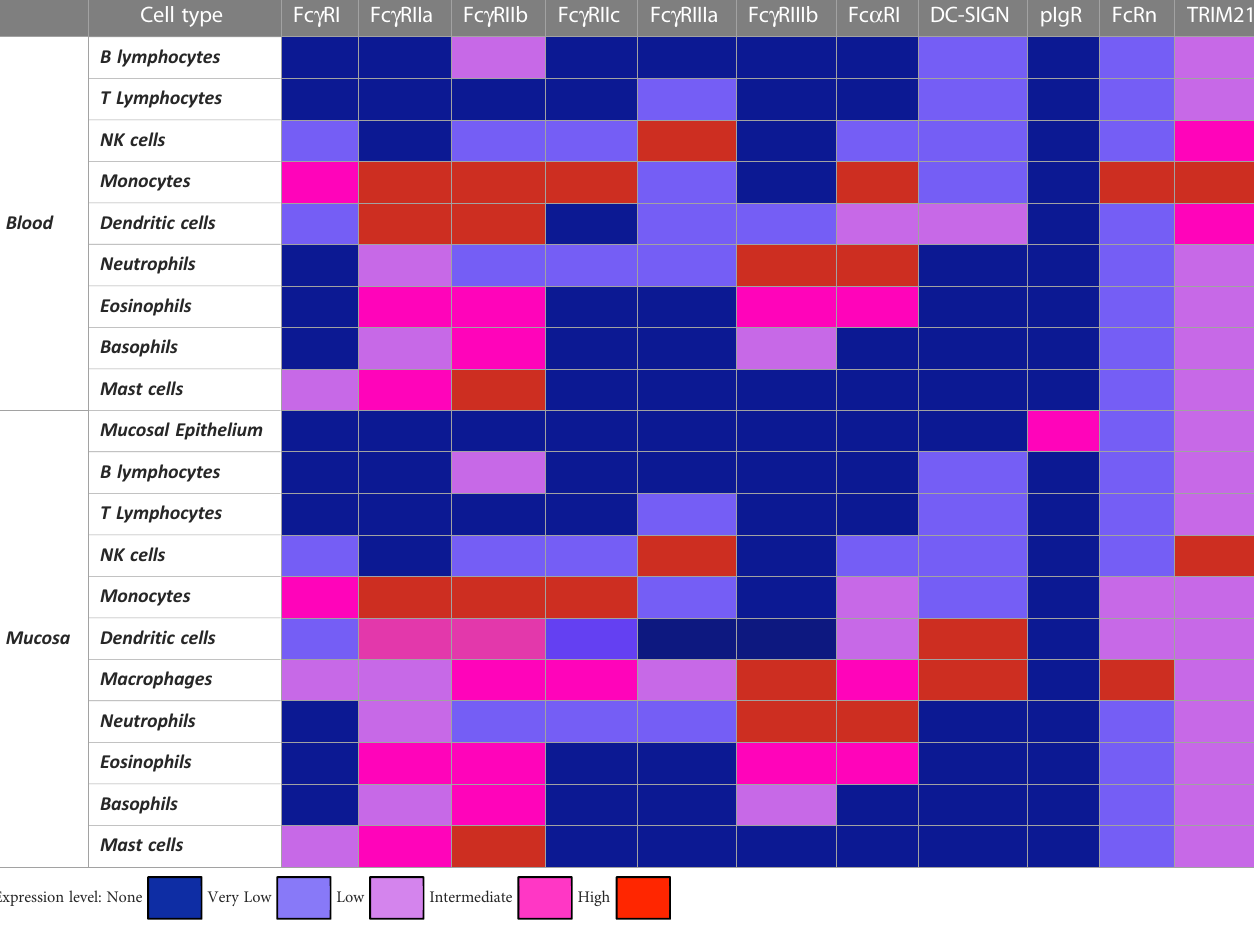
TABLE 1 Expression pattern of major FcR for IgG and IgA in human immune and non-immune